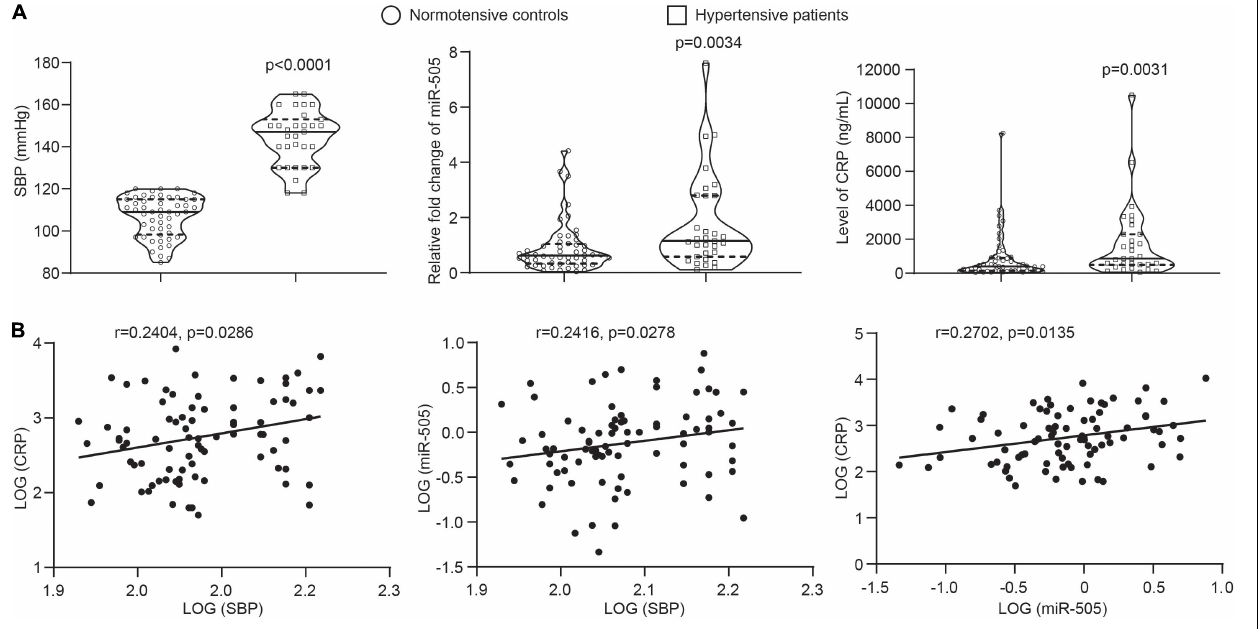
FIGURE 7 | The plasma level of miR-505 is positively correlated with CRP and SBP. (A) The plasma levels of CRP and miR-505 were analyzed in 52 normotensive subjects and 31 untreated hypertensive patients by ELISA and real-time qPCR, respectively. Data represent medians with interquartile range. P values are derived from Mann–Whitney U test. (B) Correlation between the plasma level of CRP and SBP, the plasma level of miR-505 and SBP, and the plasma levels of CRP and miR-505 were determined with Spearman’s